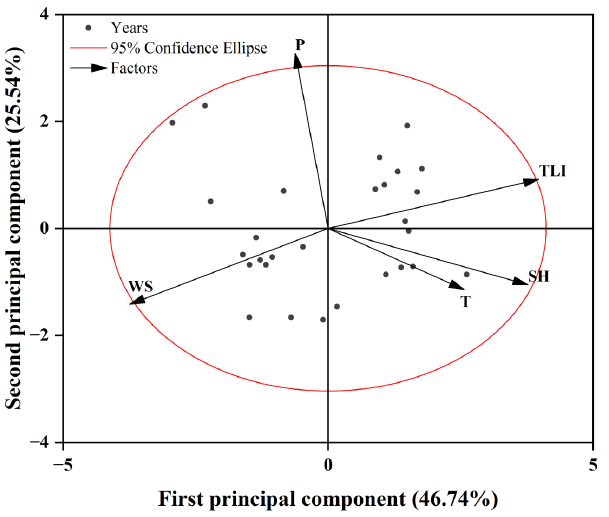
Figure 11. Identification of major influencing factors for cyanobacterial blooms in Taihu Lake with a principal component analysis. Table 1. Principal component loading matrix.